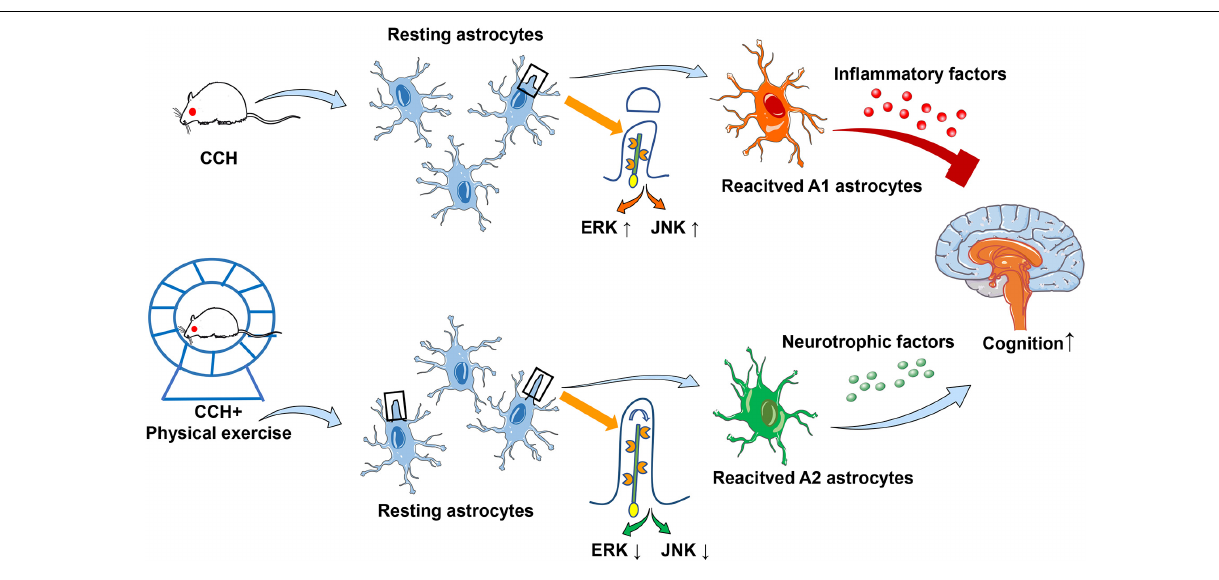
regeneration (Sterpka et al., 2020). Since primary cilia originate from the maternal centrioles, astrocytes proliferation must